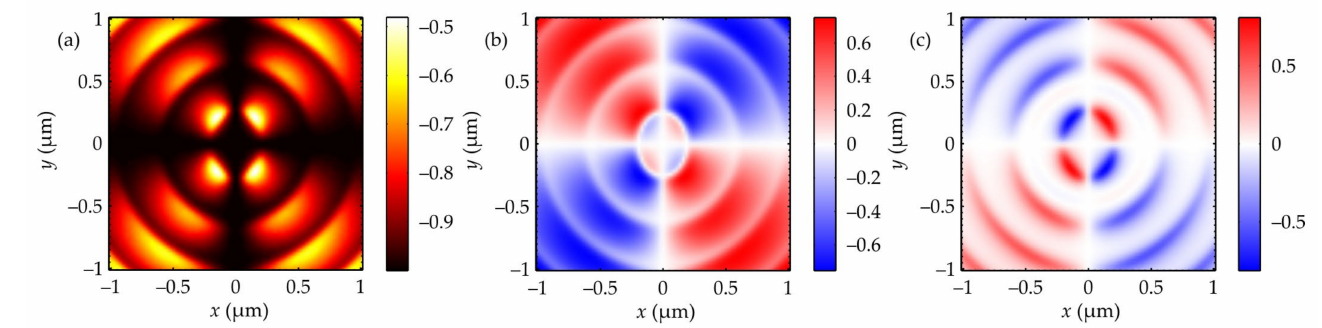
Figure 4. Distribution of the components of the normalized Stokes vector S 1 ( a ), S 2 ( b ) and S 3 ( c ) at a distance λ after the focus.